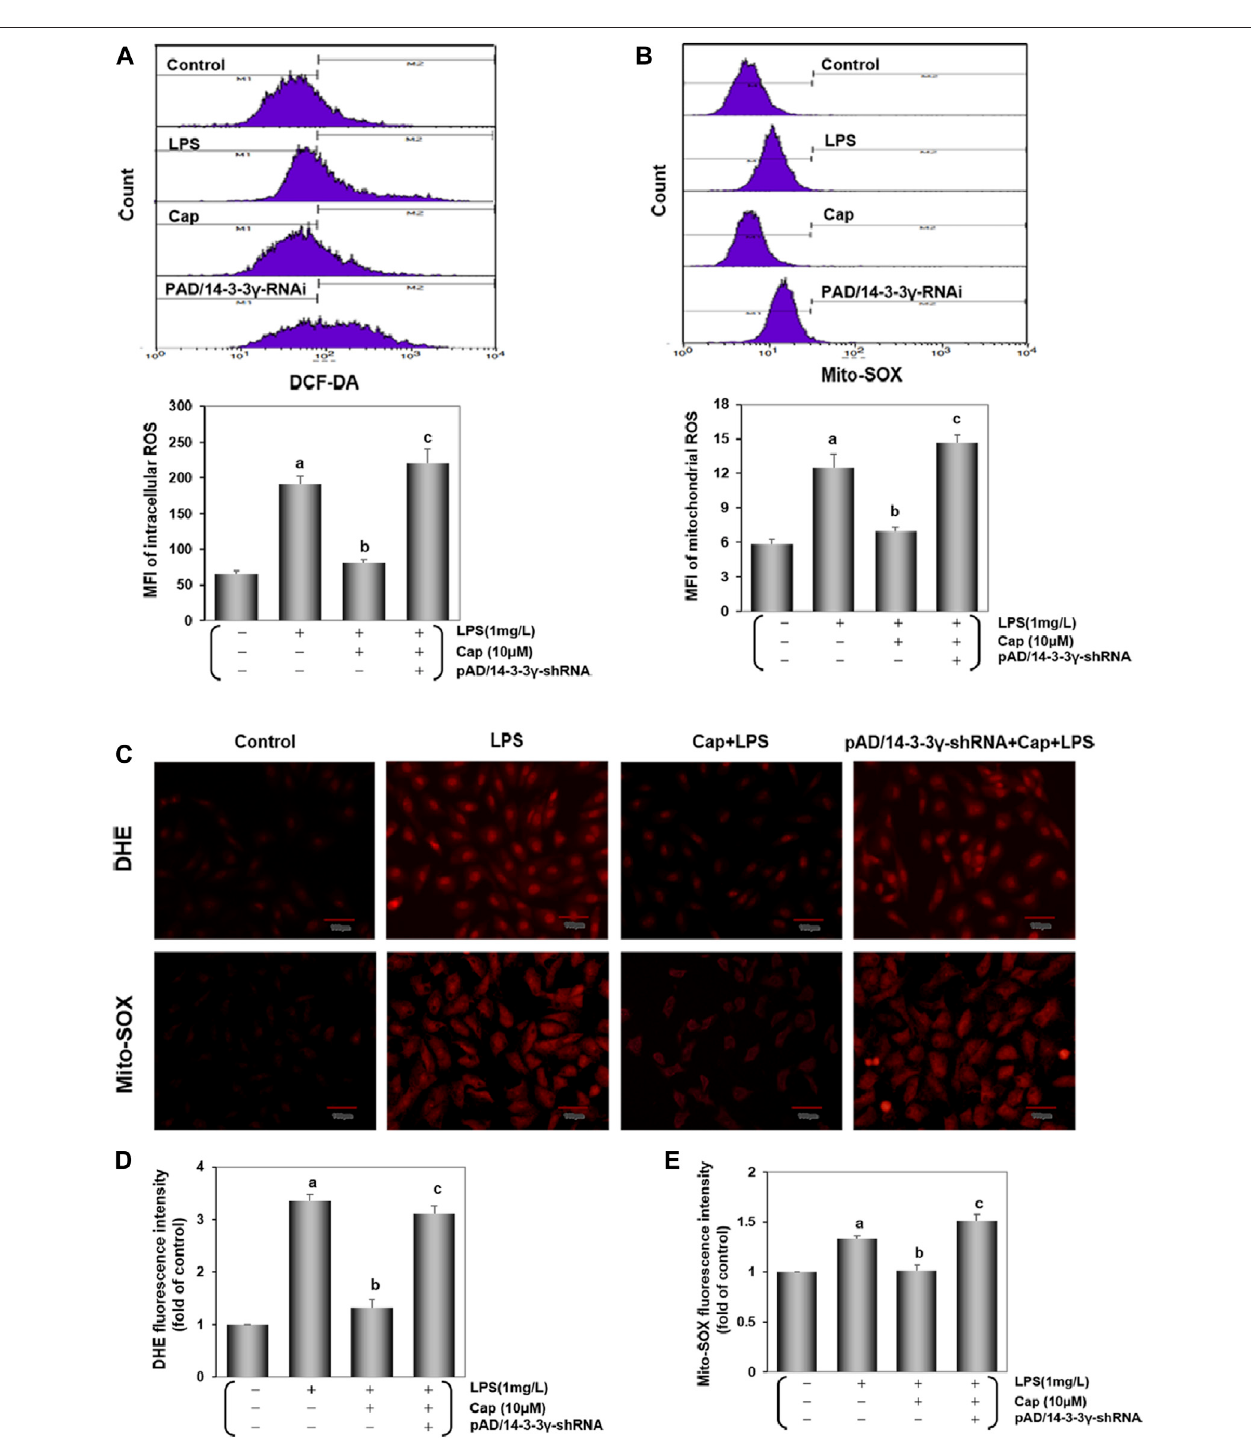
FIGURE 5 | Cap decreases Intracellular/mitochondrial ROS generation in cardiomyocytes injured after LPS challenge. (A) DCF-DA indicated intracellular ROS generation. (B) Mito-SOX measured mitochondrial ROS level. (C) Intracellular/ mitochondrial ROS were stained by DHE/Mito-SOX probe. (D) and (E) Fluorescence intensity of DHE and Mito-SOX were analyzed by ImageJ software. Values were presented as mean ± SEM. For fi ve individual experiments, a: P < 0.01 vs. the control group; b: P < 0.01 vs. the LPS group; c: P < 0.01 vs. the Cap+LPS group.